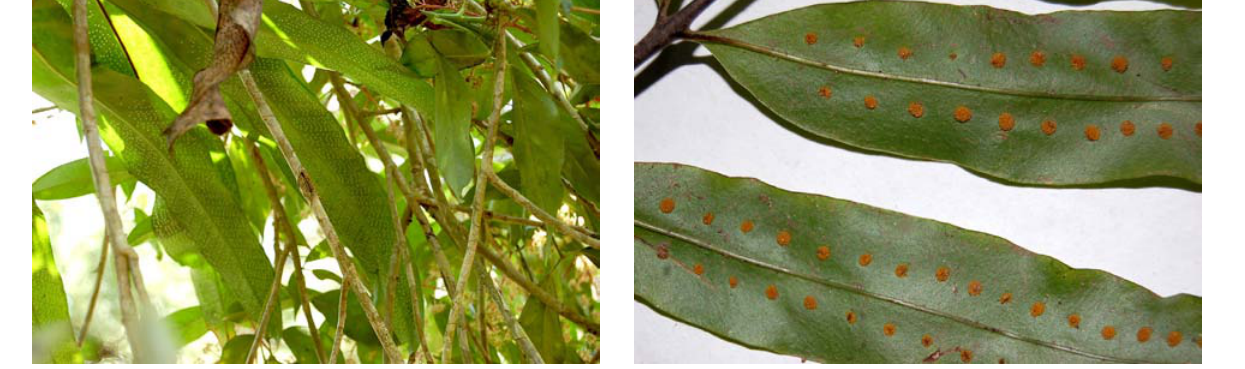
Image 17. Microsorum